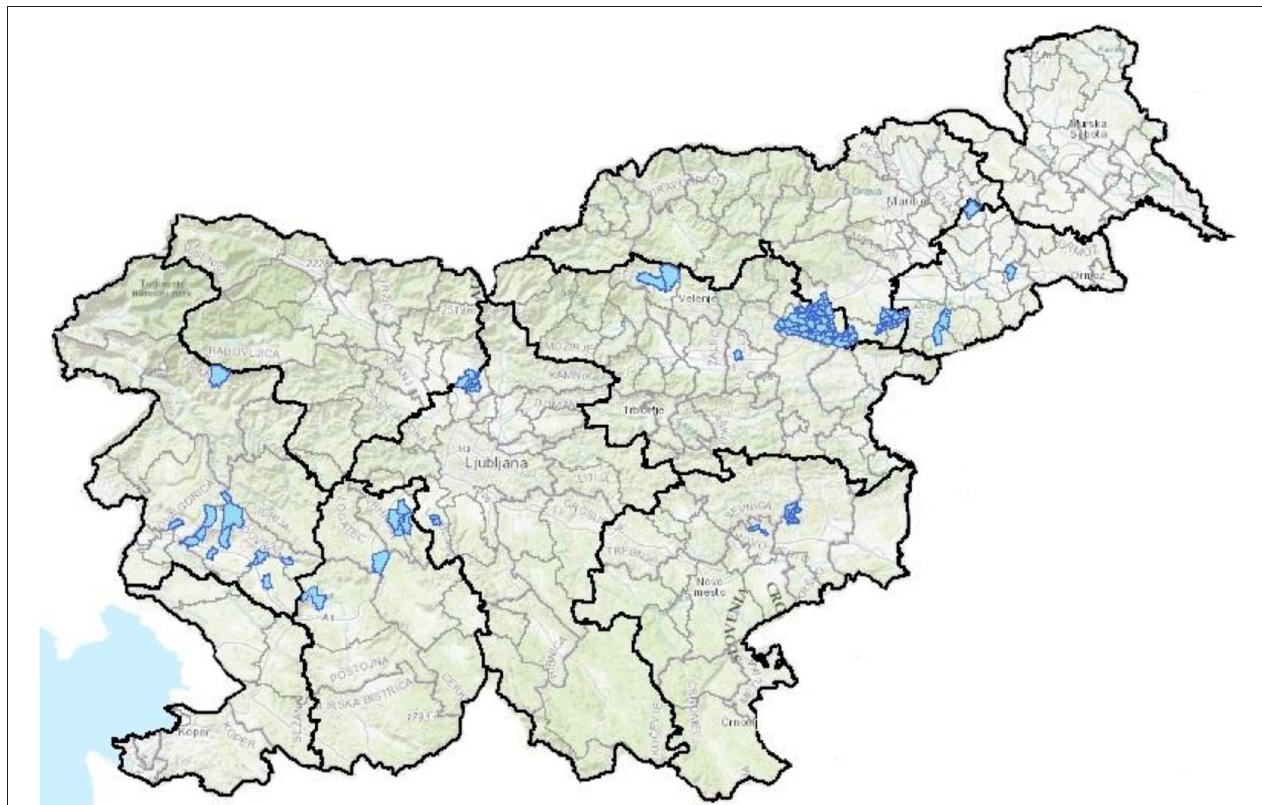
FIGURE 4 | Location of the all 106 anthrax districts in Slovenia, in 2019